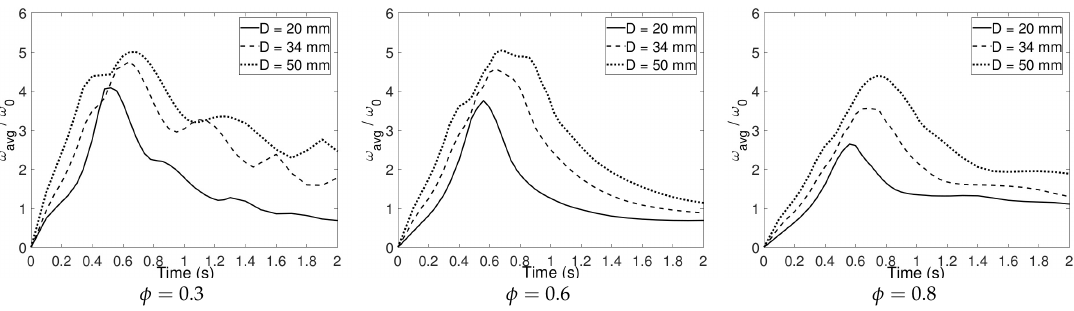
Figure 15. The effect of piston diameter on average vorticity.